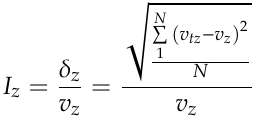
Figure 7. The visualized airflows in ( a ) the y-z plane, ( b ) the “ y-z plane ( x = 15)”, and ( c ) the “ y-z plane ( x = 30)”. The real size for each sub-image is 141.8 mm × 109 mm.